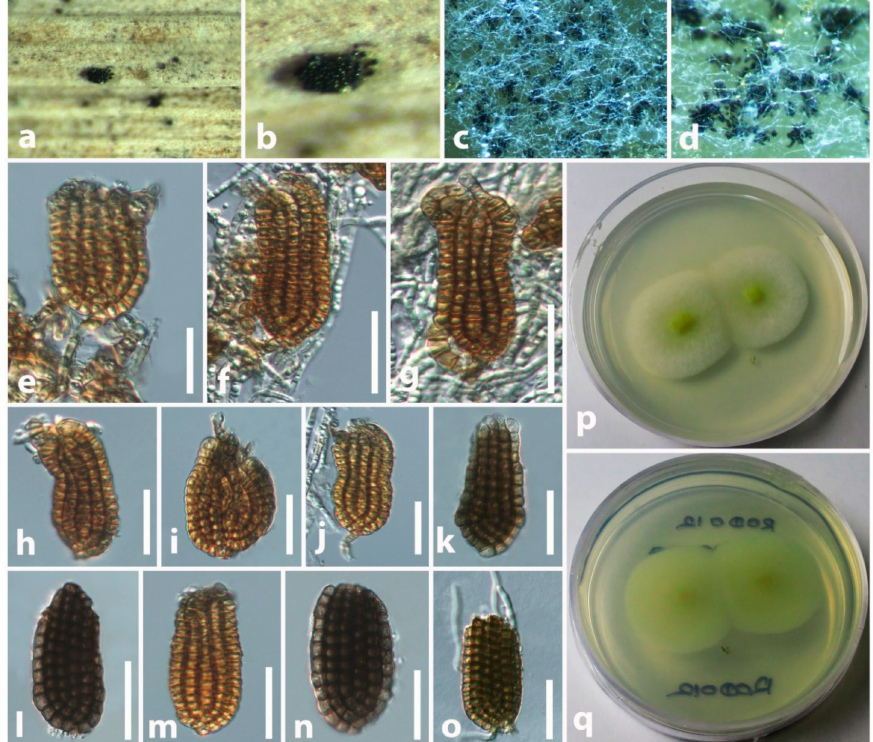
Figure 5. Dictyosporium digitatum (CMUB 39981, new host record ). ( a ) Sporodochia on a dead leaf of Cyperus aggregatus . ( b ) Close-up of Sporodochium. ( c , d ) Sporodochia on the culture. ( e – g ) Conid- iogenous cells with conidia. ( h – n ) Conidia. ( o ) A germinating conidium. ( p ) Colonies from above (on PDA/7 days). ( q ) Colonies from below (on PDA/7 days). Scale bars: ( e – o ) = 30 µ